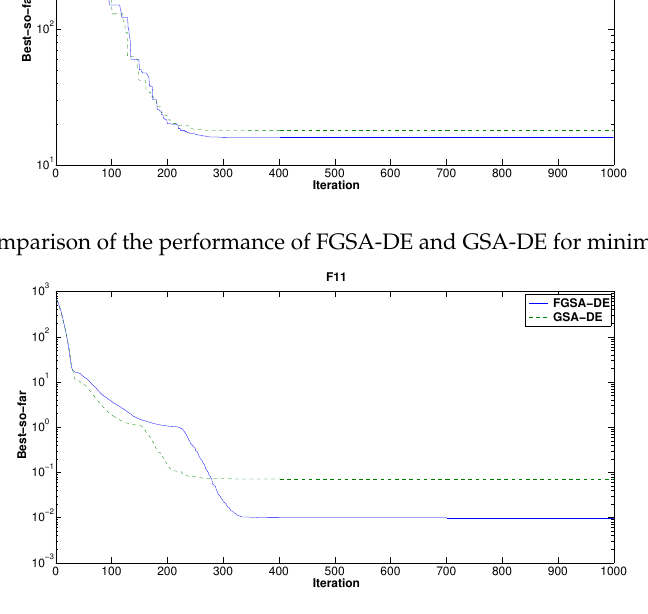
Figure 13. Comparison of the performance of FGSA-DE and GSA-DE for minimization of F